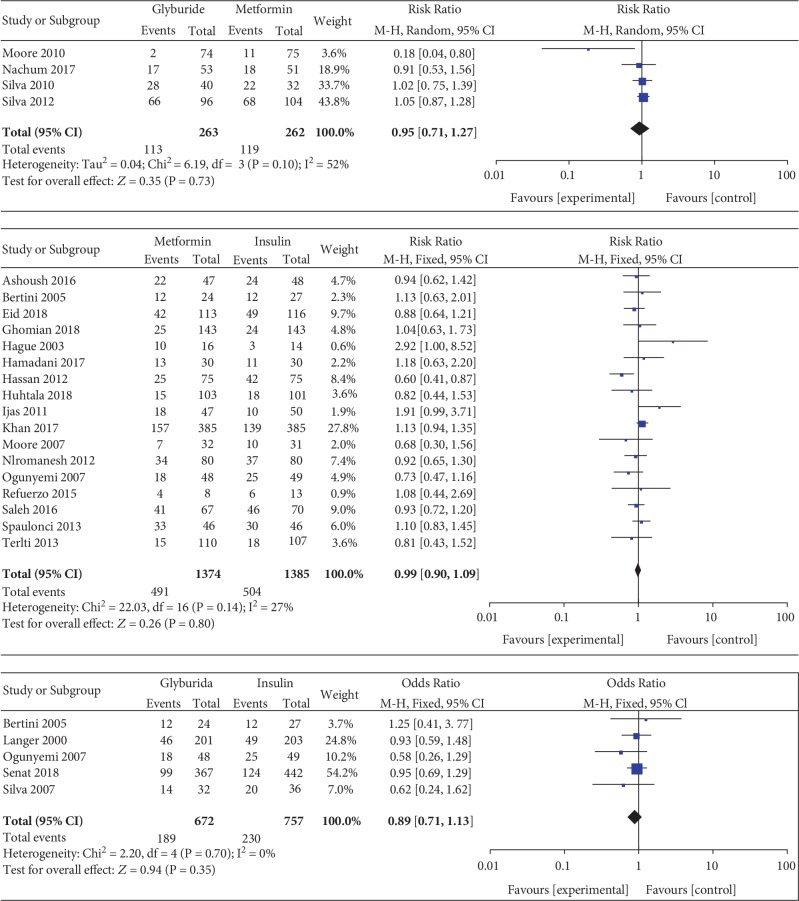
Cesarean section.